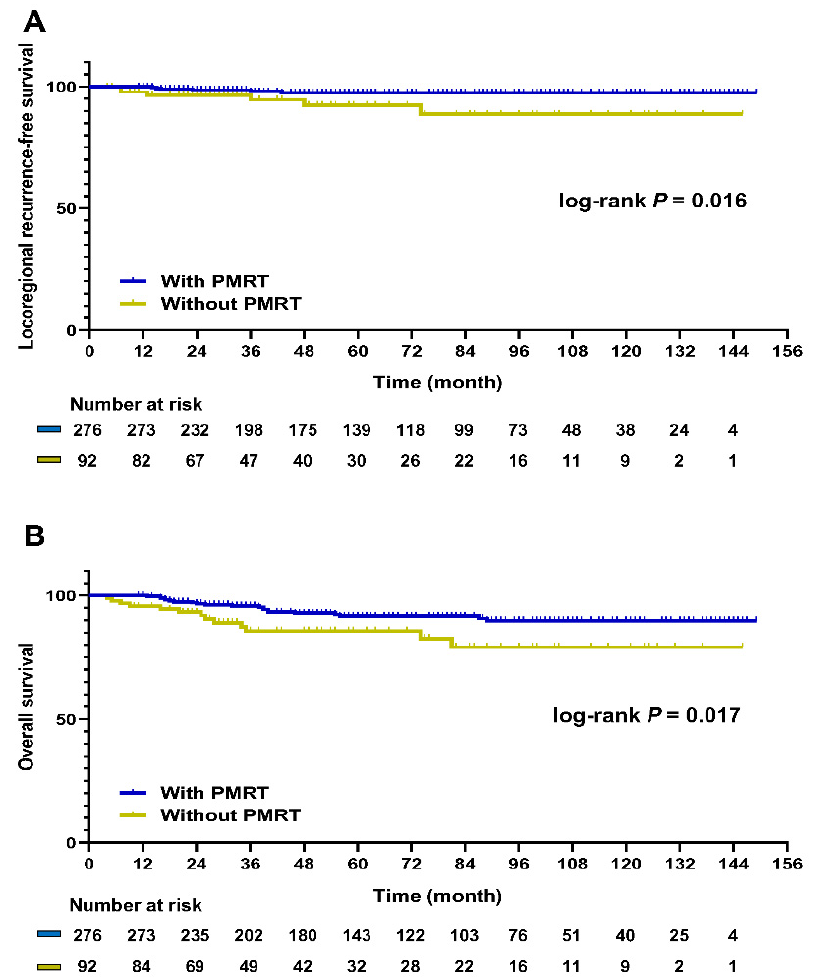
Figure 1. Kaplan–Meier survival curve of LRRFS and OS according to PMRT status after 1:3 PSM. ( A ) LRRFS ( p = 0.016); ( B ) OS ( p = 0.017). LRRFS, locoregional recurrence-free survival; OS, overall survival; PMRT, post-mastectomy radiotherapy; PSM, propensity score matching.